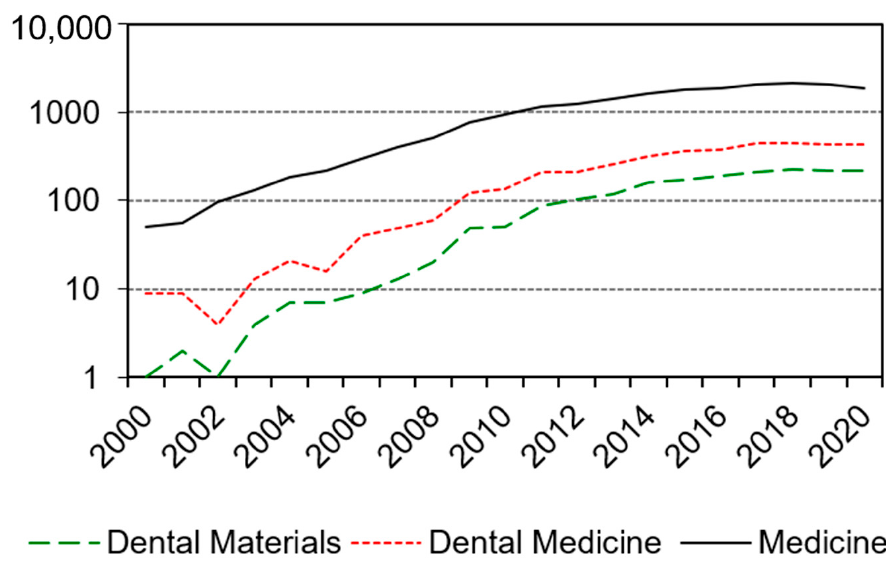
Figure 1. Hits identified on PubMed for the terms “microCT” or “micro X-ray tomography”. Swain and Xue [1] categorise the different clinical topics in which the method can be used in dentistry: